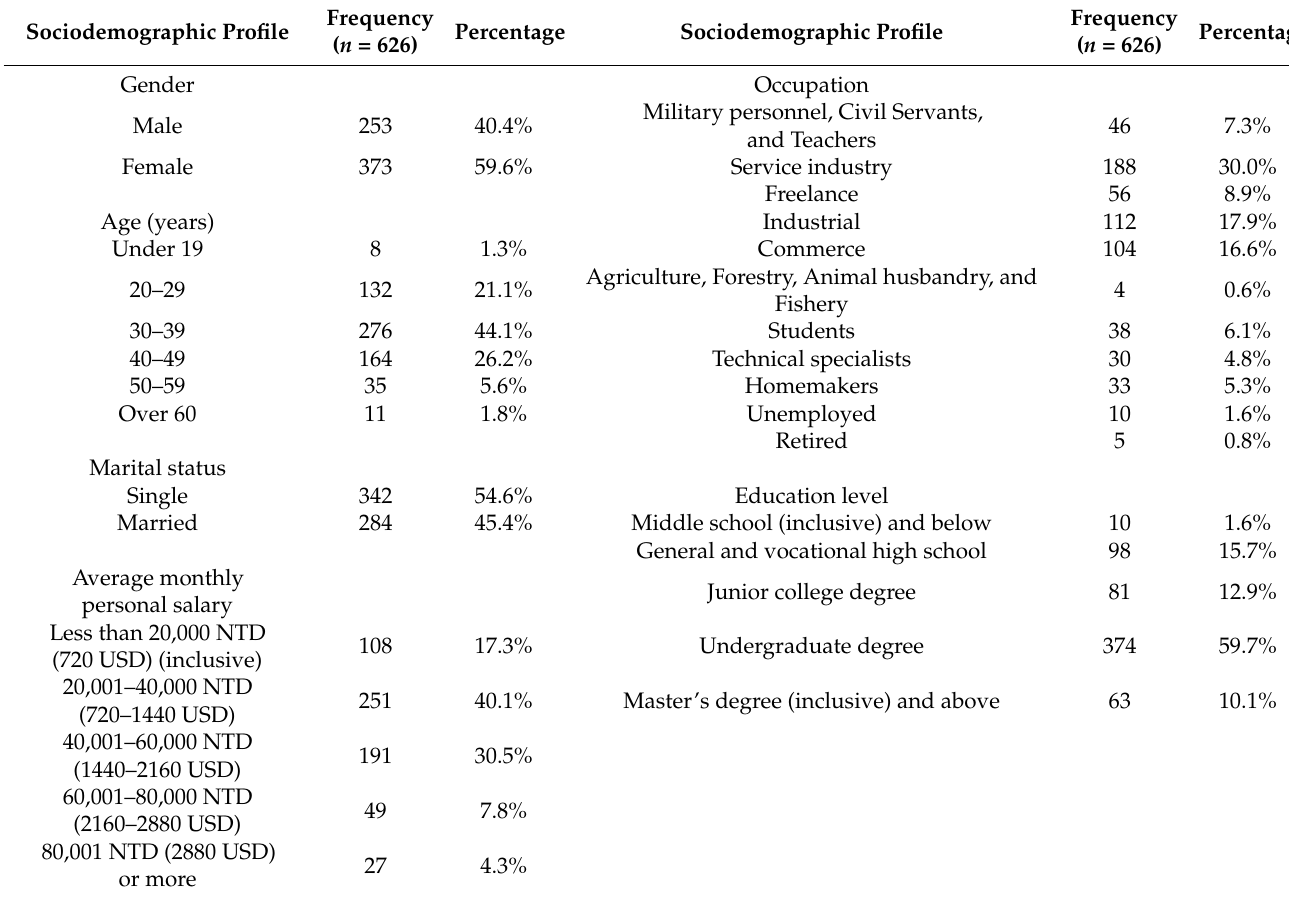
Table 1. Profiles of